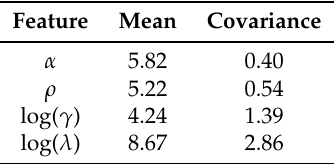
Table 4. Gaussian distribution of each waveform